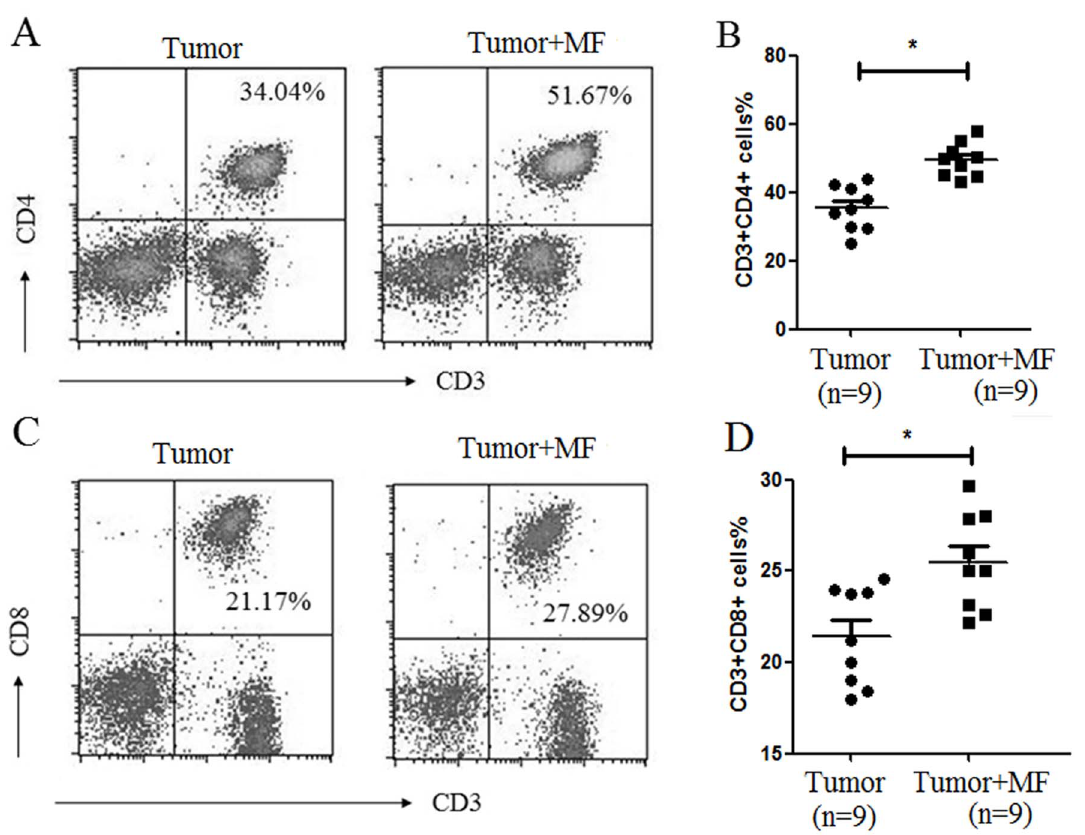
Figure 5. Magnetic fields enhances the expression of CD40 in Dendritic Cell. Proportion of CD11c + DC (A) and CD11c + CD40 + DC (B) in PBMC was detected by flow cytometry. (C) The mean proportion of CD11c + CD40 + DC in PBMC for each group (Mean 6 s.e.m.). (D) The mean proportion of CD11c + CD40 + DC in tumor infiltrating lymphocytes for each group (Mean 6 s.e.m.). * P , 0.05, ** P , 0.01 or ns=No significant difference.